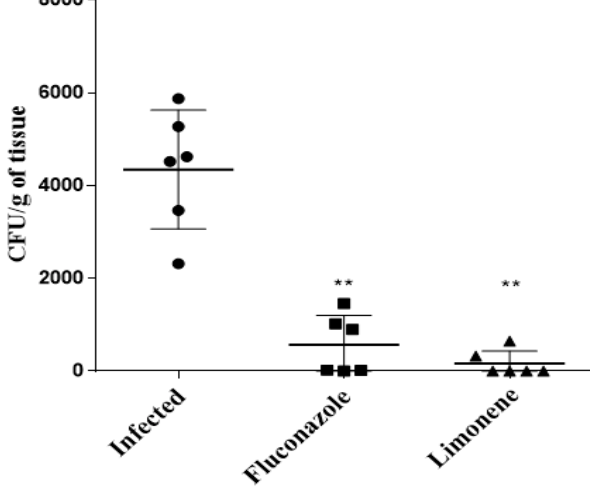
Figure 4. Colony-forming units (CFUs) of the vaginal canal of BALB/c mice that were infected intravaginally with 3 × 10 5 of C. albicans ATCC 90028. Animals ( n = 6) were treated for 7 days with 10% limonene in cream or with 10 mg/kg of fluconazole in cream and sacrificed after 8 days of infection. The CFUs were quantified after 24 h of growth. ** p < 0.01 compared with the control group ( C. albicans ATCC 90028 without treatment; ANOVA with post-hoc Tukey’s test). Experiments were conducted in three different times.